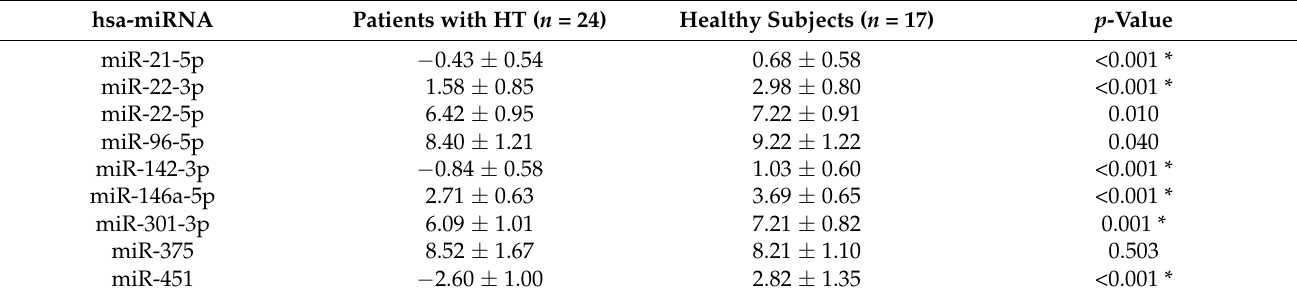
Table 3. MiRNA ∆ Ct values according to the selected miRNAs of patients with Hashimoto’s thyroidi- tis and healthy subjects. Data are shown as mean ± standard deviation. Patients with HT ( n =